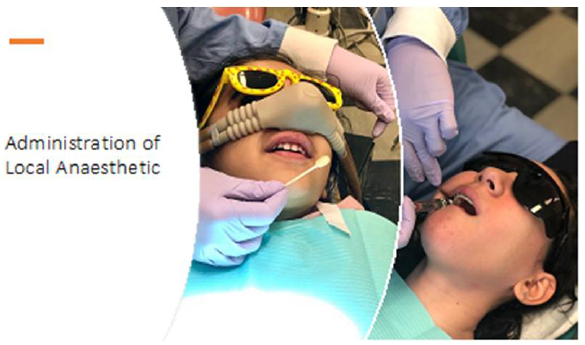
Figure 1. Example of an image shared with participants during the interview. Table 1. Example of information shared with participants and associated questions during the interview. Dental Procedure and